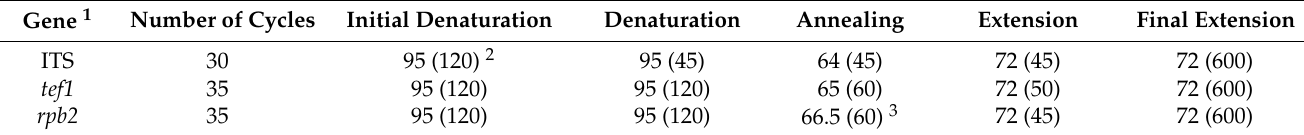
Table 1. PCR conditions used in this